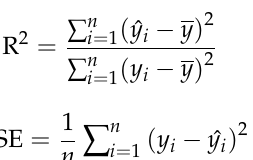
Figure 12. Schematic view of long-short term memory (LSTM) model: c in the left upper part represents the internal memory of the unit; h on the left lower part represents the hidden state; i , f and o mean input gate, forgetting gate and output gate, respectively; the three parameters were calculated by using the same equation with different parameter matrixes, and then defined the data availability of x ( t ), h ( t − 1) and the current data used for the next l; and g represents the internal hidden state.